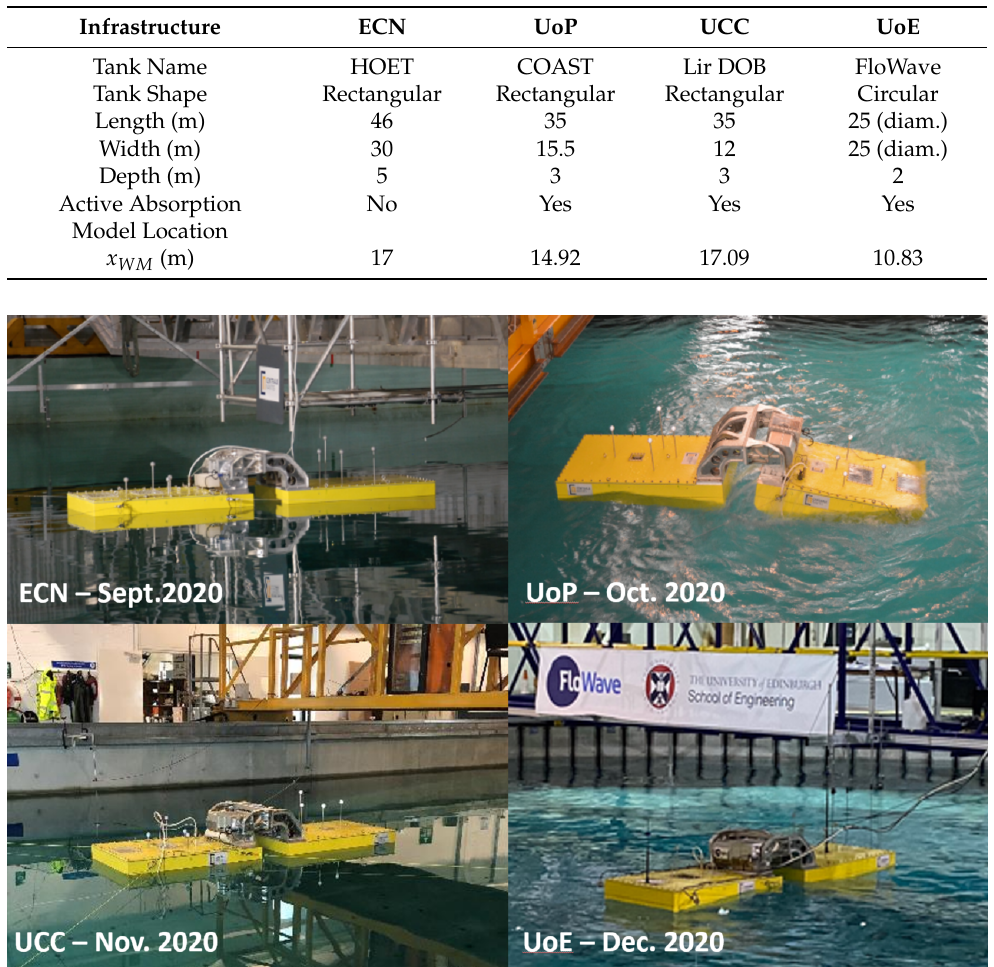
Figure 2. The raft WEC under test in the four